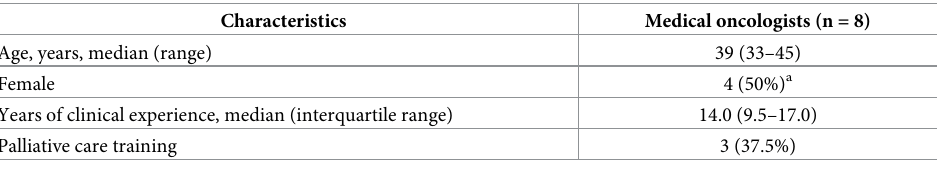
Table 2. Clinician characteristics (n =